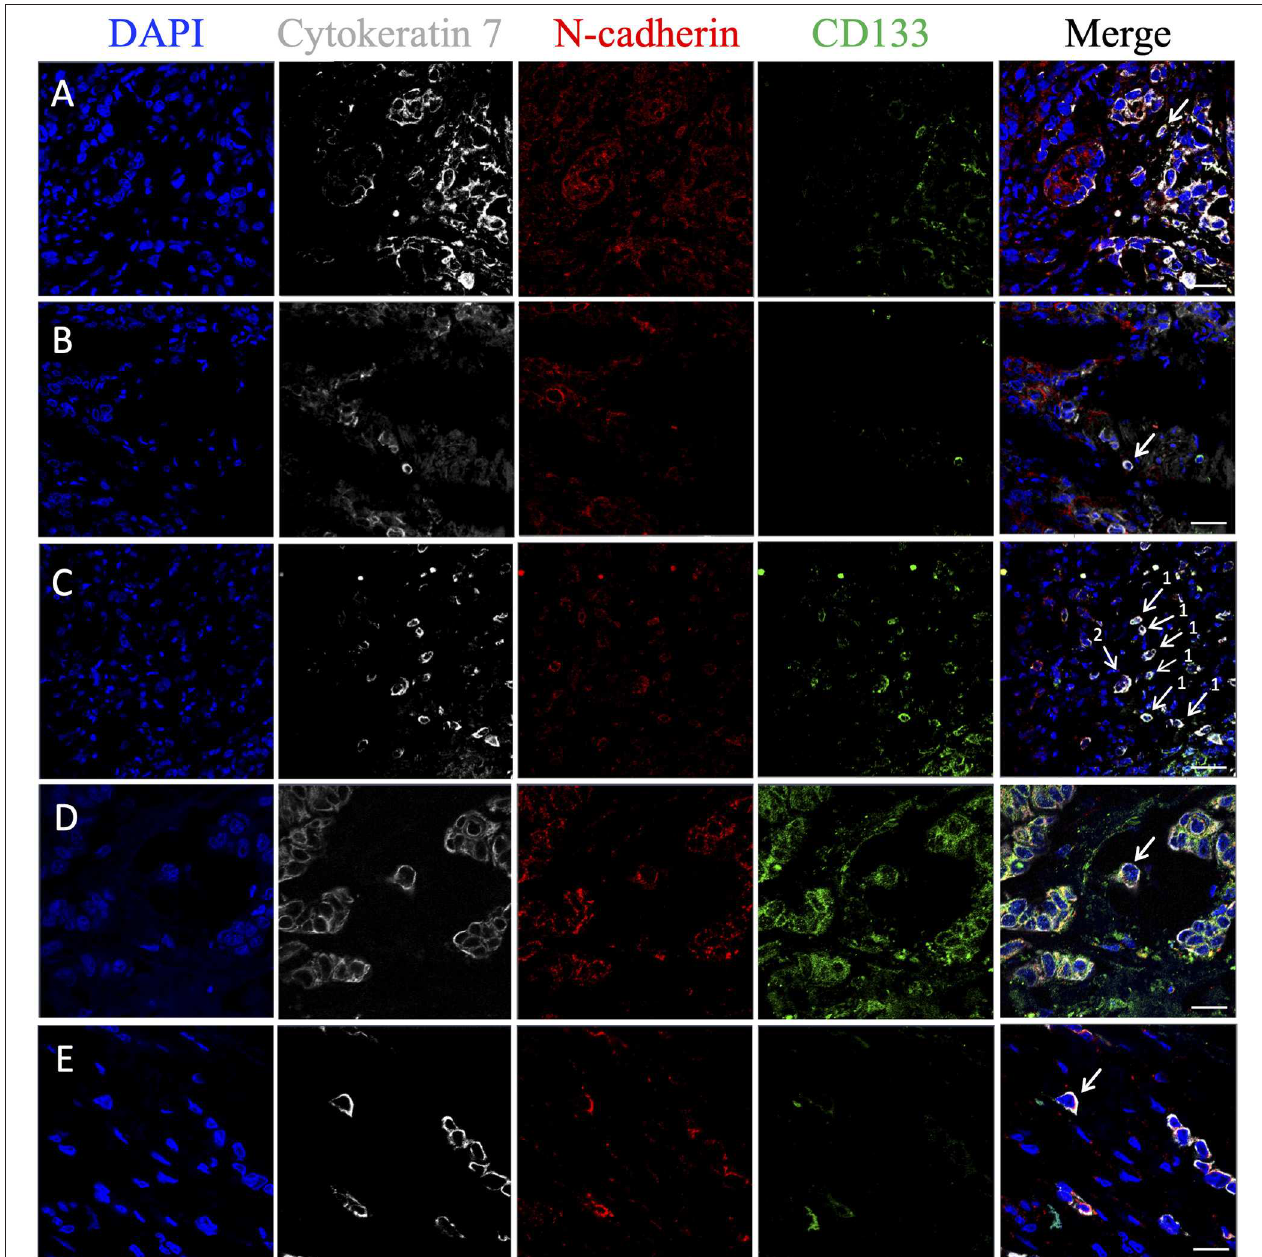
FIGURE 6 | Phenotypic heterogeneity of eSTCs and mSTCs in stem and advanced EMT features. (A) Stem mSTC with advanced EMT (CK7 + CD133 + N-cadherin + ) near the multicellular structures. (B) mSTC without the stem and EMT features (CK7 + CD133 − N-cadherin − ) among microenvironment cells. (C) Stem mSTC with advanced EMT (CK7 + CD133 + N-cadherin + ) (1) and the group of two tumor cells (were not considered as STCs in the study) with stem and advanced EMT features (2) among microenvironment cells. (D) Stem eSTC with advanced EMT (CK7 + CD133 + N-cadherin + ) near the multicellular structures. (E) Nonstem eSTC with advanced EMT (CK7 + CD133 − N-cadherin + ) near the multicellular structures. Scale bar, 50 µ m (A–C) and 20 µ m (D,E) .